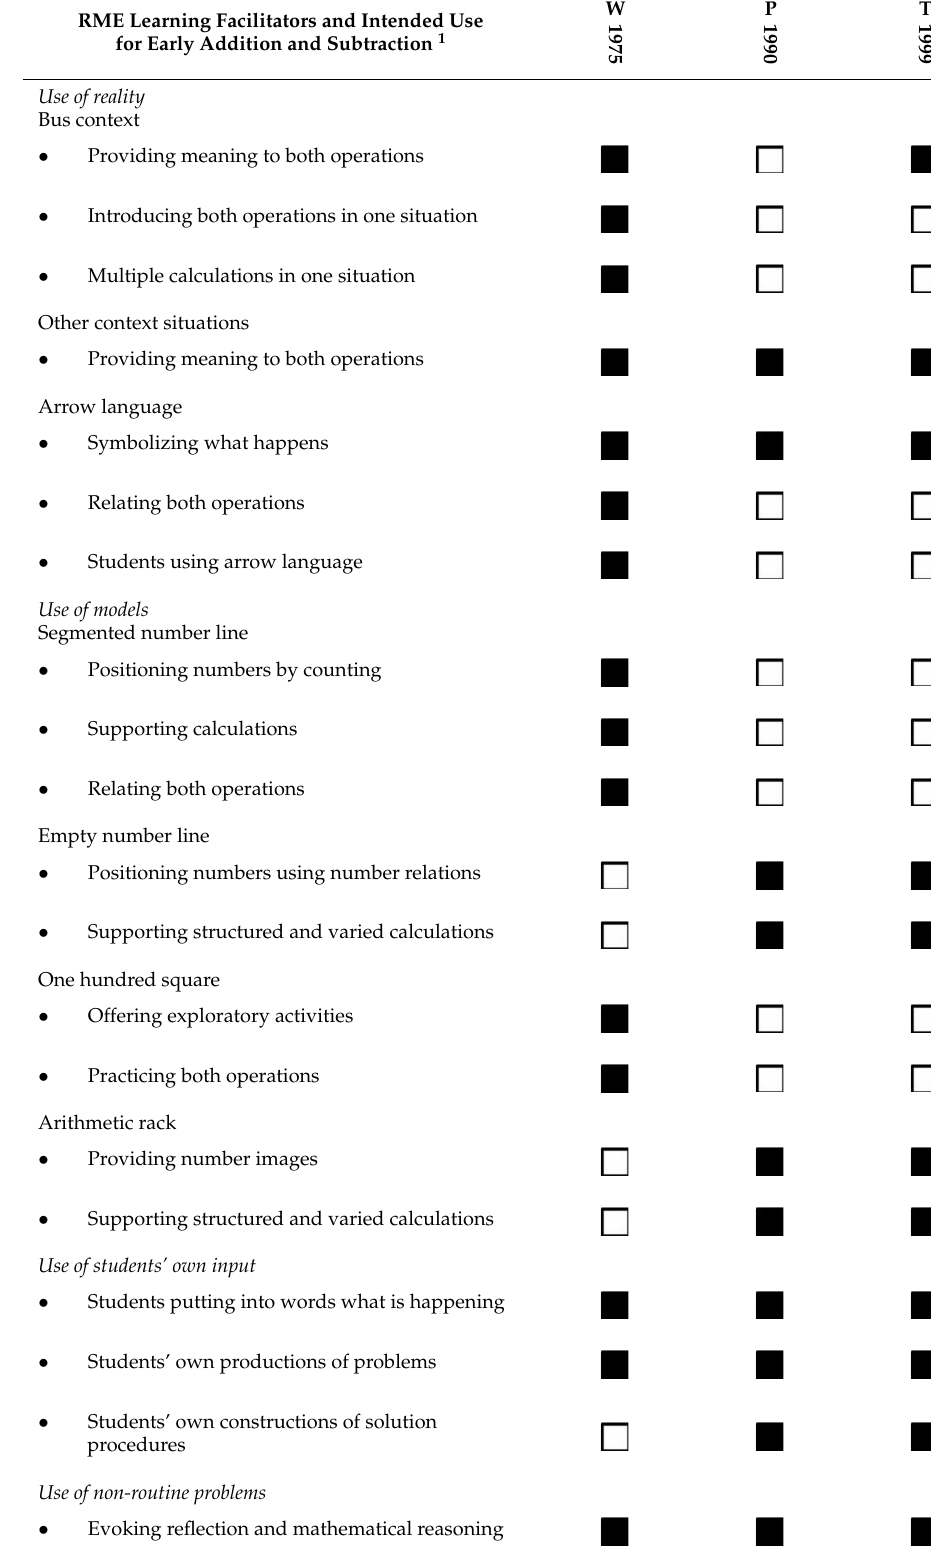
Table 1. Realistic Mathematics Education (RME) learning facilitators and their intended use for early addition and subtraction as indicated in Wiskobas (W), Proeve (P), and TAL (T). W P RME Learning Facilitators and Intended Use for Early Addition and Subtraction 1